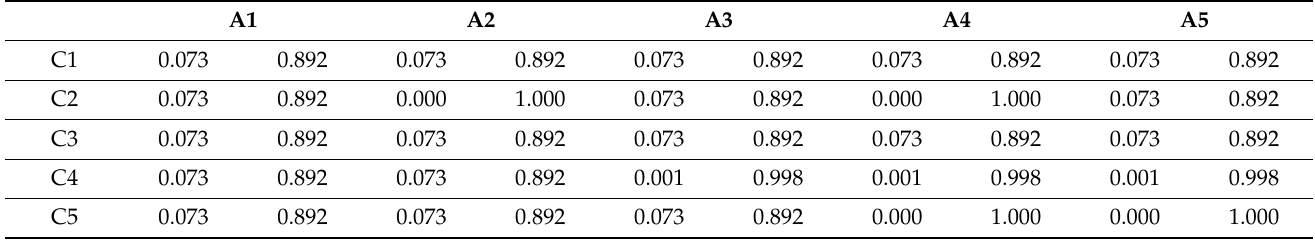
Table 5. The weighted decision matrix V